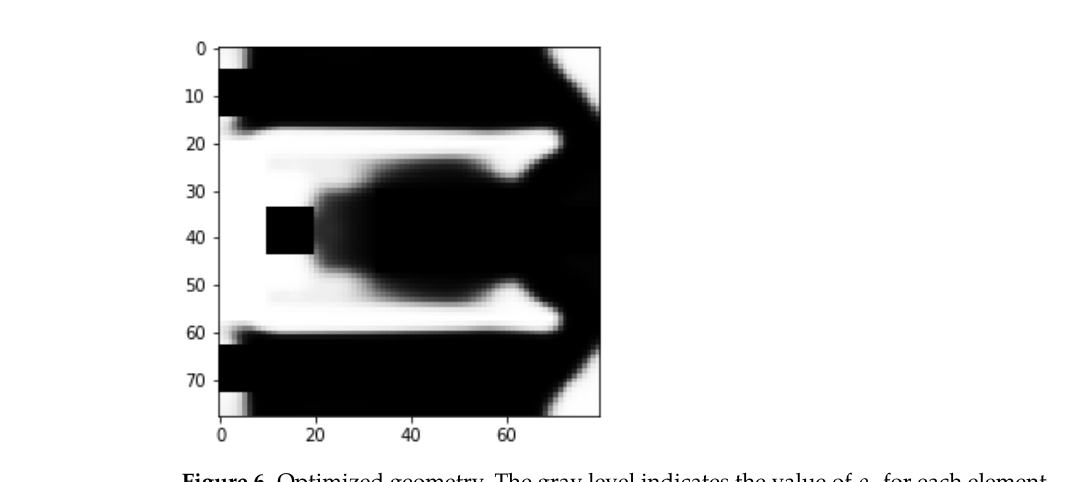
Figure 6. Optimized geometry. The gray level indicates the value of ρ e for each element. To achieve a manufacturable design, the final geometry is cut-off at ρ e = α (volume fraction), i.e., elements with ρ e > α are considered full and those with ρ e ≤ α are considered void. The boundary of the geometry is smoothed as the final step of this conversion. Figure 7 shows the mode shapes of the first two resonant modes of the structure after conversion. They value at f 1 = 74.573 Hz and f 2 = 79.054 Hz, respectively. The corresponding open- circuit voltage and maximum power outputs are presented in Figures 8 and 9. For the computation of the electrical power output, we assumed optimally matched load resistances at each frequency. Note that both outer patches are connected in parallel.